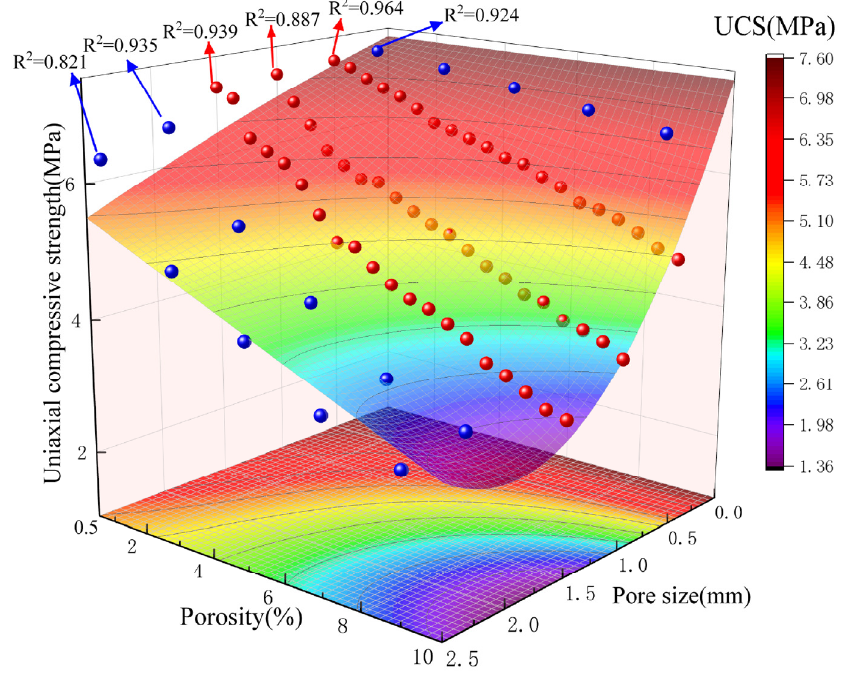
Figure 8. Uniaxial compressive strength fitting effect.